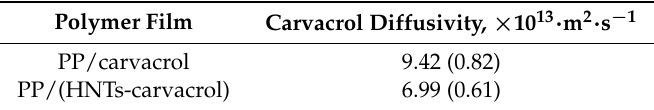
Table 6. Calculated diffusivity values for carvacrol from various films, determined by fitting the mathematical model for short-time diffusion-limited desorption from a polymer film surface to the release profile of carvacrol from the films measured by TGA (the numbers in parenthesis indicate standard deviations obtained from at least three independent